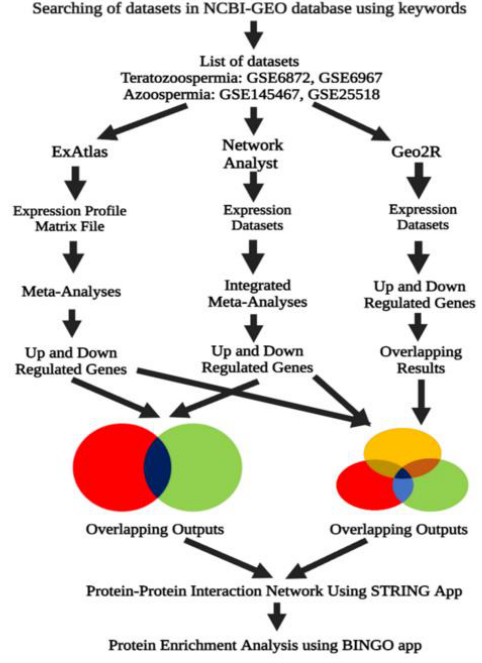
Figure 1. The diagrammatic illustration showing the workflow for the identification of potential biomarker genes common to teratozoospermia and azoospermia, introducing an in silico approach. Meta-analysis using three different analyses, i.e., ExAtlas, Network Analyst, and GEO2R, resulted in overlapping outputs which were then used to study protein-protein interaction (PPI) and protein enrichment analysis using the STRING and BINGO application, respectively.